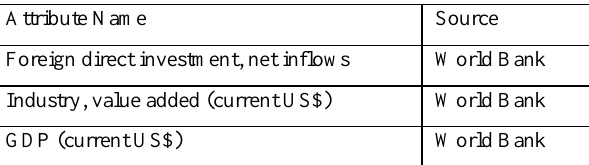
Table 16. Attributes used in APD